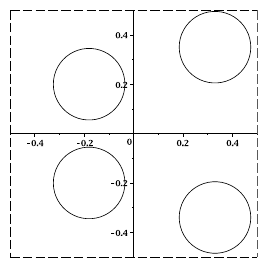
Figure 2. Configuration of the unit cell with four inclusions considered in